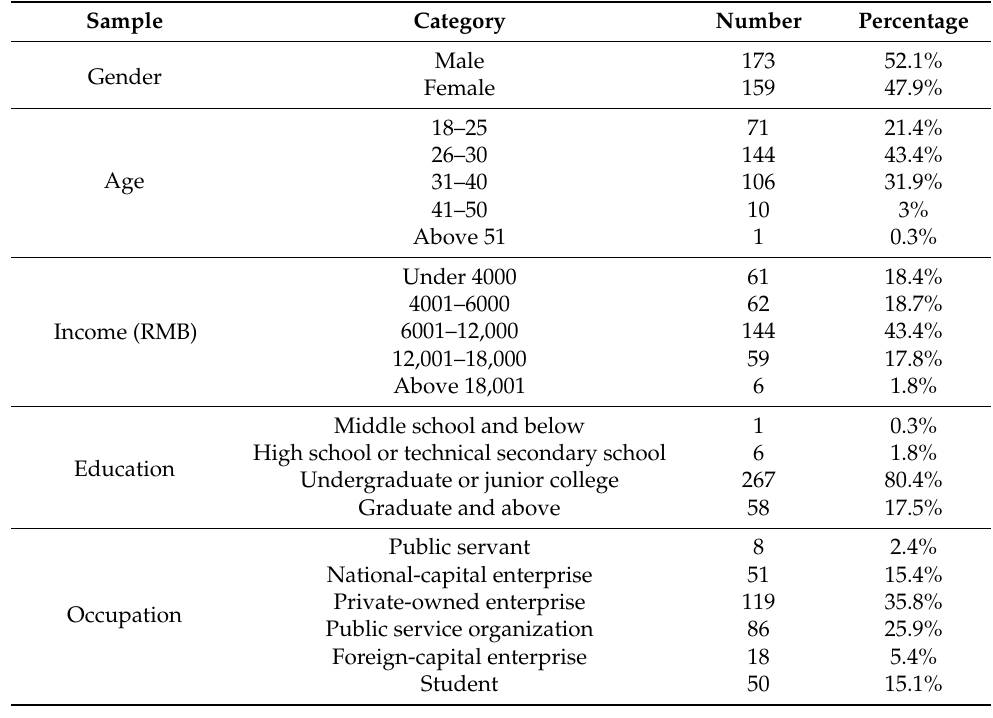
Table 2. The basic information of the